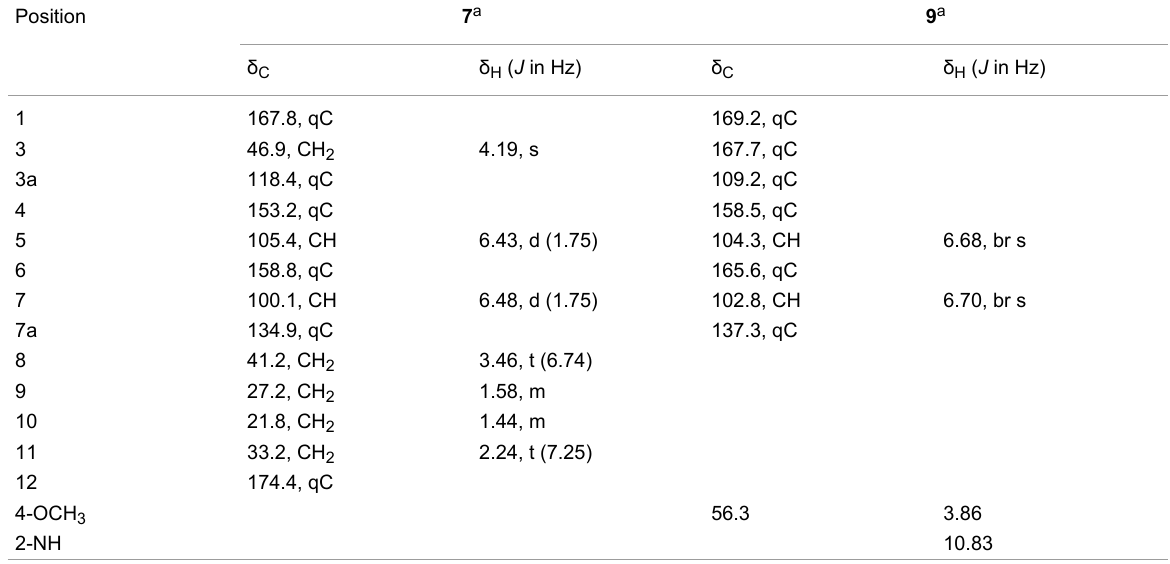
Table 2: 1 H and 13 C NMR spectroscopic data for compounds 7 and 9 in DMSO- d 6 .